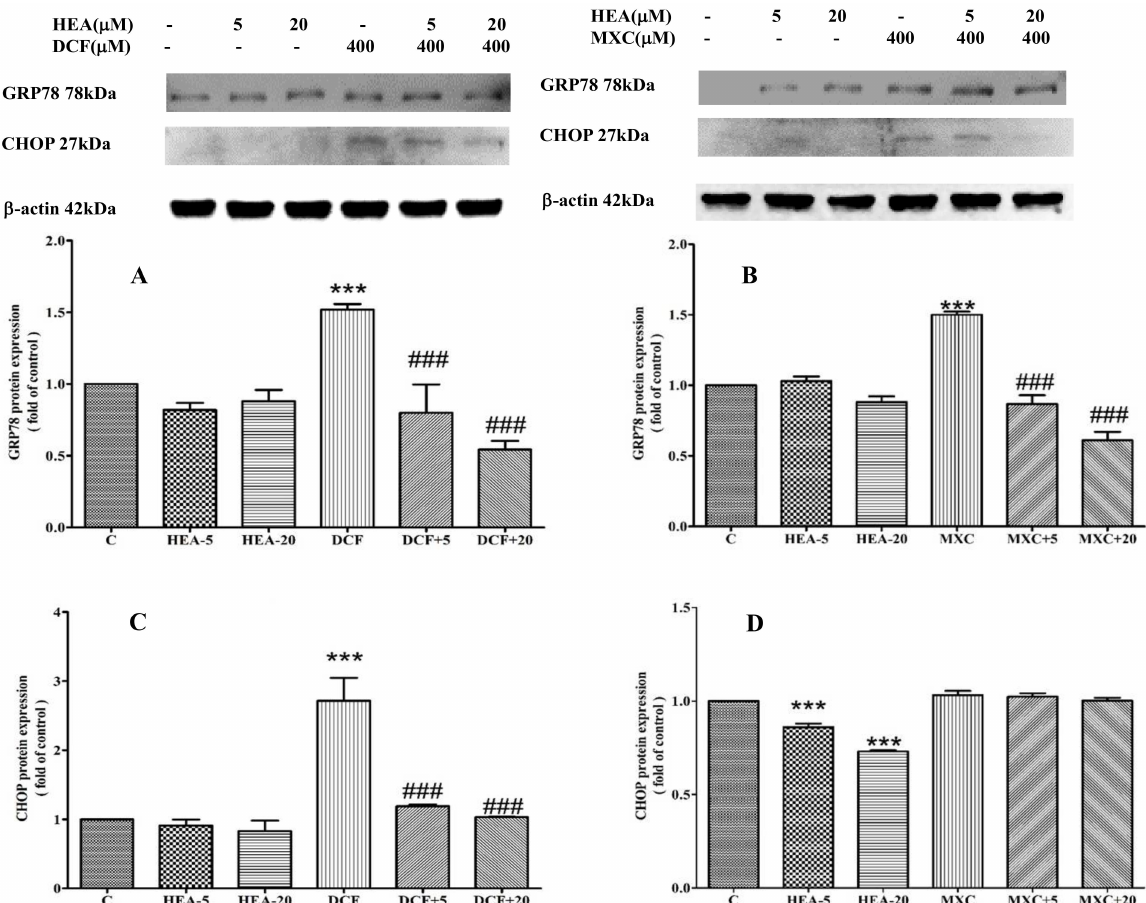
Figure 7. Effect of HEA on intracellular GRP78 and CHOP protein expression levels in HK–2 cells exposed to DCF ( A , C ) and MXC ( B , D ), respectively, for 24 h. The intracellular protein expression was detected by Western blot. C: Control, HEA: HEA 20 µ M, DCF: DCF 200 µ M, DCF+5: DCF 200 µ M + HEA 5 µ M, DCF + 20: DCF 200 µ M + HEA 20 µ M, MXC: MXC 400 µ M, MXC + 5: MXC 400 µ M + HEA 5 µ M, MXC + 20: MXC 400 µ M + HEA 20 µ M. Data are presented as mean ± SD from three independent experiments (*** p < 0.001 versus the control group; ### p < 0.001 versus the DCF or MXC